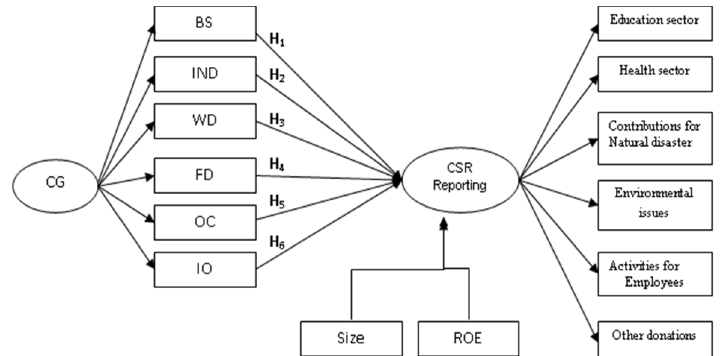
Figure 1 . Graphical representation of the